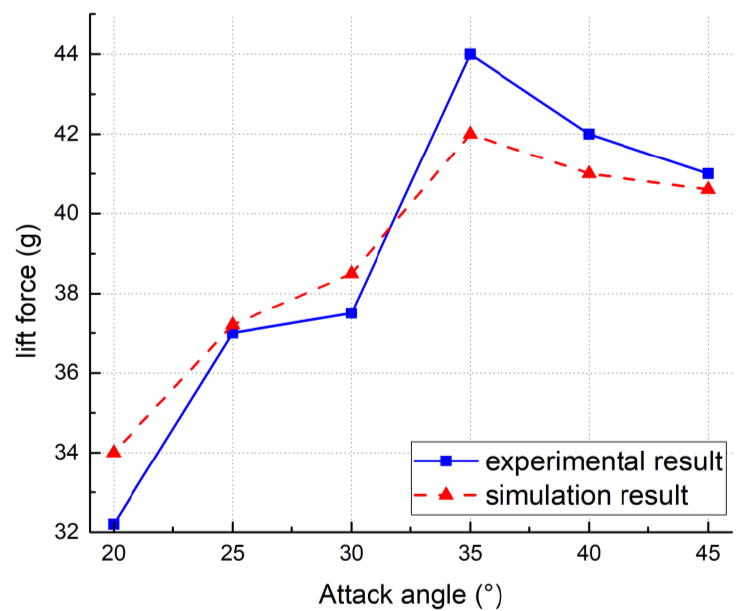
Figure 14. Lift force of the experiment and CFD results.